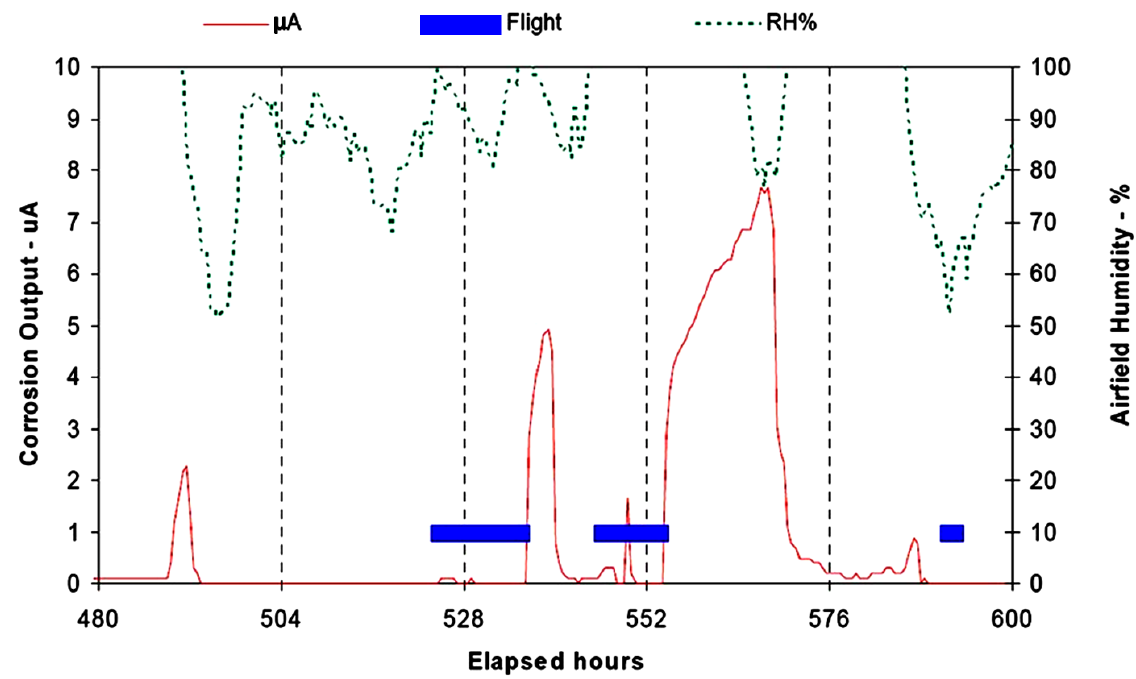
Figure 2 . Typical output from a P- 3C corrosion monitor, showing corrosion current, μA, periods of flight, and airfield Figure 2. Typical output from a P-3C corrosion monitor, showing corrosion current, µ A, periods of flight, and airfield relative humidity (RH), reprinted with permission from [12]. relative humidity (RH), reprinted with permission from